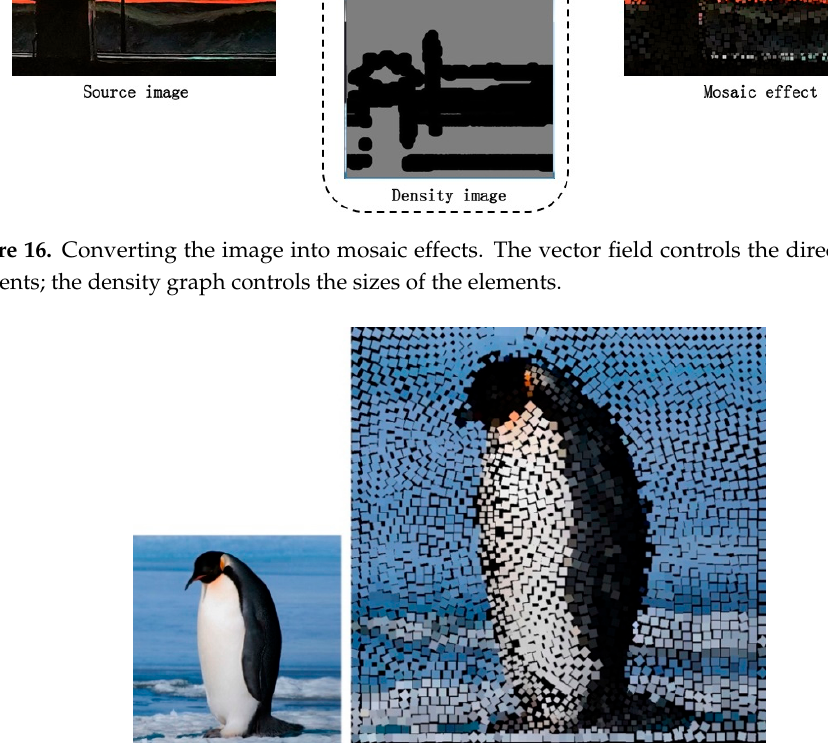
Figure 17. Synthesis results based on image feature analysis.